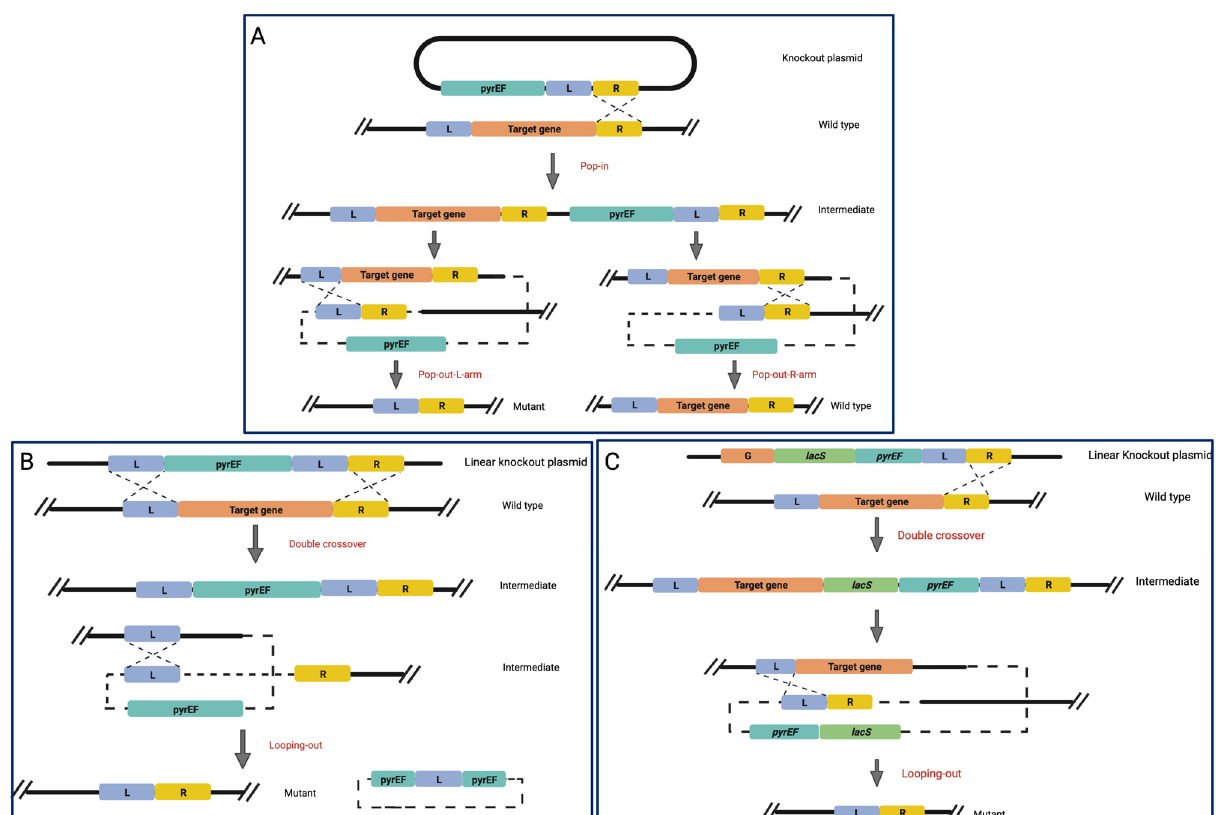
Figure 1. Schematic representation of three genome editing methods developed in H. volcanii . ( A ) Plasmid integration and segregation (PIS); ( B ) Marker replacement and looping out (MRL); ( C ) Marker insertion and target gene deletion (MID). In all panels, L and R arms are highlighted in blue and yellow, respectively; lacS and pyrEF genes markers are in green and teal, respectively. The pyrEF selection is used to illustrate the schemes, but any other efficient markers might be used [45]. This figure was created with BioRender.com (accessed on 7 December 2022).